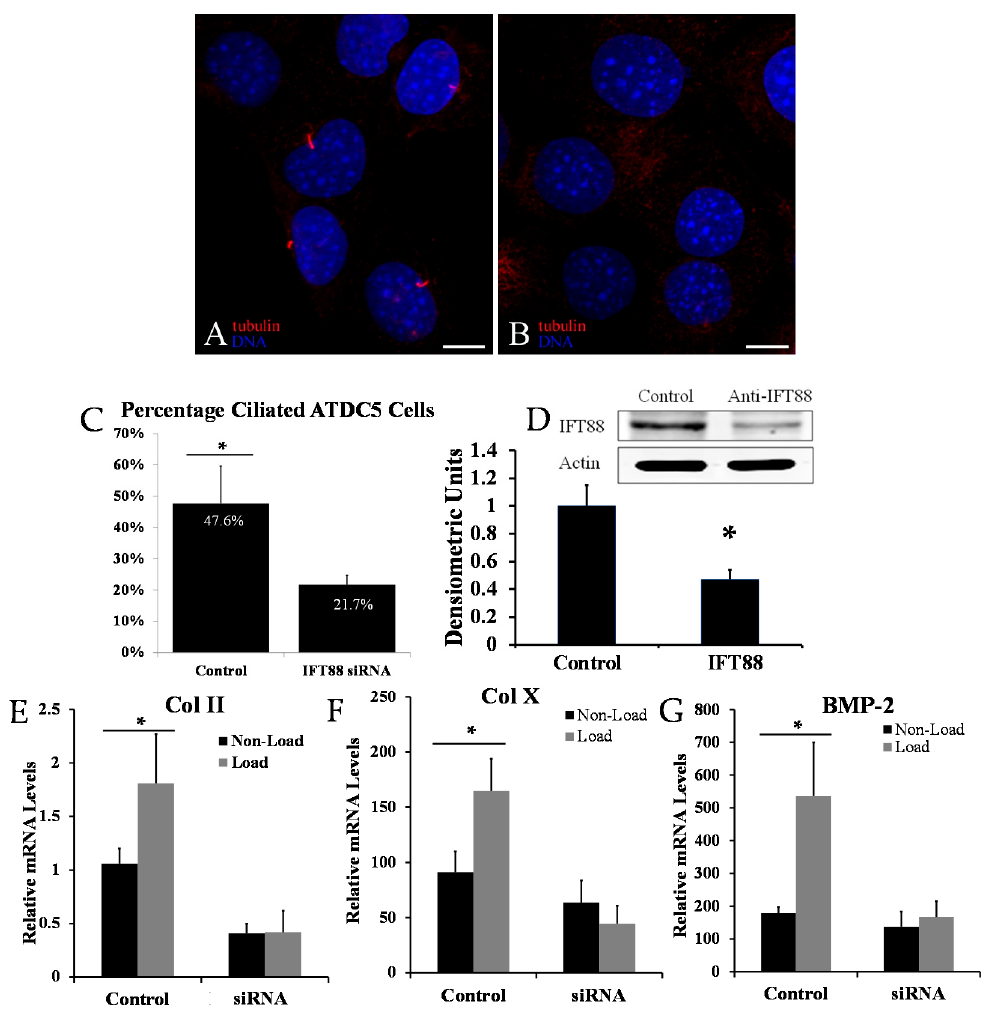
Figure 1. Confocal microscope image showing a field of ATDC5 mouse chondroprogenitor cells transfected with scrambled control ( A ) or intraflagellar transport protein 88 (IFT88) siRNA ( B ). Primary cilia are extending from the cell surface of the control-group cells ( A ) but not present in the IFT88 siRNA cells ( B ); acetylated α -tubulin is stained red; DNA is stained blue with DAPI (scale bars: 10 µm). IFT88 siRNA transfection decreased the number of ciliated cells by immunocytochemistry from 47.6% in controls to 21.7% ( C ). Western blot demonstrates effective knockdown of IFT88 by transient transfection. Quantitation values of IFT88 protein levels normalized to actin are presented ( D ). Significant differences in relative Type II collagen (Col II) mRNA ( E ); Type X collagen (Col X) mRNA ( F ); and bone morphogenetic protein 2 (BMP-2) mRNA ( G ) between loaded and non-loaded conditions in control transfected cells were not significant in IFT88 transfected cells. Values normalized to 18S rRNA. Statistically significant values are represented by